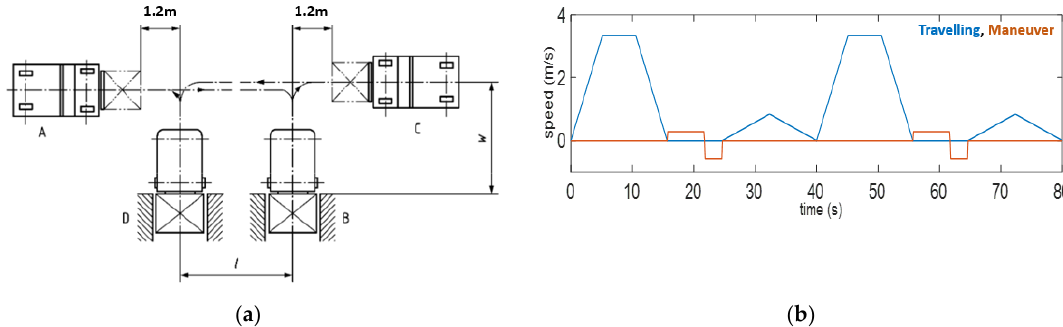
Figure 1. ( a ) Verein Deutscher Ingenieure (VDI) drive cycle protocol (l = 30 m and w = 3 m) [NF ISO 16769-2], ( b ) Speed profile from VDI 60 protocol (forklift: EFG 110 Jungheinrich )—(blue) travelling speed (orange) fork speed during handling maneuver.